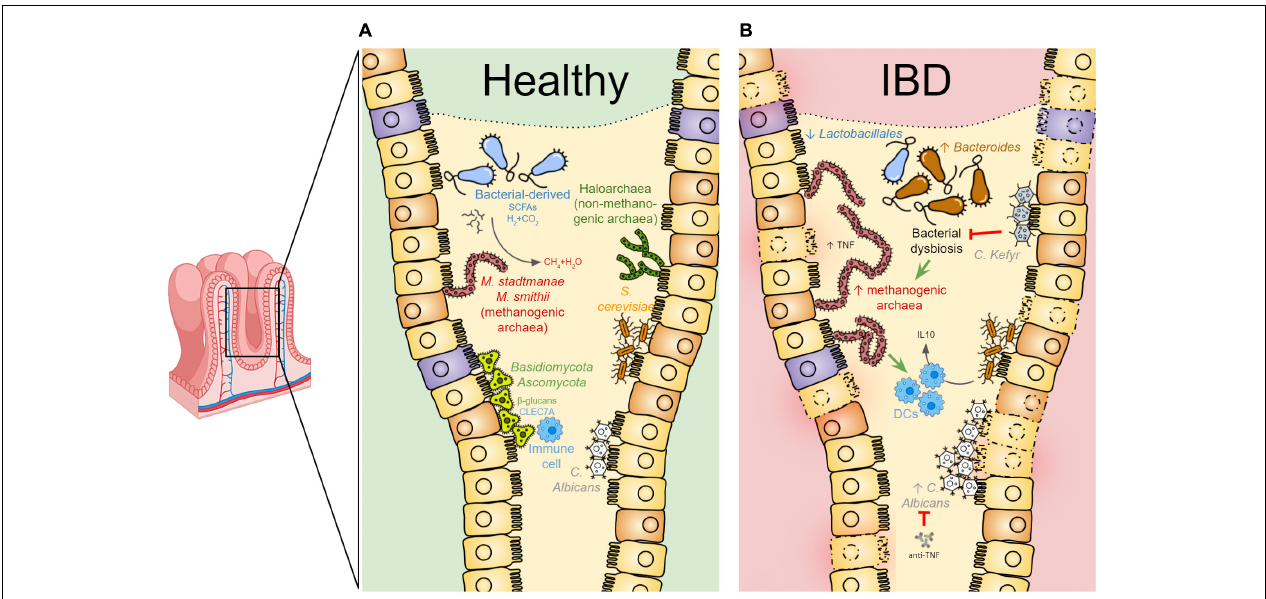
FIGURE 1 | The gut archaeome and mycobiome communities in health and disease. (A) In healthy conditions, the intestinal mucosa is colonized by specific archaeal and fungal species contributing, together with the other components of the microbiota, to the overall gut physiology. The archaeal methanogens [i.e., Methanobrevibacter (M.) smithii and Methanosphaera (M.) stadtmanae species] exist in a syntrophic relationship with bacterial species within the gut. Short-chain fatty acids (SCFAs) as well as hydrogen gas (H 2 ), produced by anaerobic bacterial fermentation, are used by methanogens to decrease the gas pressure in the colon by consuming H 2 and CO 2 to produce methane. In physiologic conditions, the human gut is also colonized by the haloarchaea. In parallel, the human gut mycobiota is predominantly characterized by Ascomycota, Basidiomycota, Candida (C.) albicans, and Saccharomyces (S.) cerevisiae. Fungi can be detected by the host immune system through CLEC7Aa C-type lectin receptor recognizing fungal wall β -glucans. (B) In IBD patient intestine, bacterial dysbiosis may contribute to increased methanogen species abundance, known to likely promote TNF production and activate dendritic cells (DCs), eventually contributing to the inflammatory state of the mucosa. Candida kefyr acts as a probiotic during intestinal inflammation by re-establishing the Bacteroides and Lactobacillales abundances. S. cerevisiae may exert anti-inflammatory effects by stimulating the IL10-production by DCs. This image has been designed using resources from https://www.twinkl.fr/ and